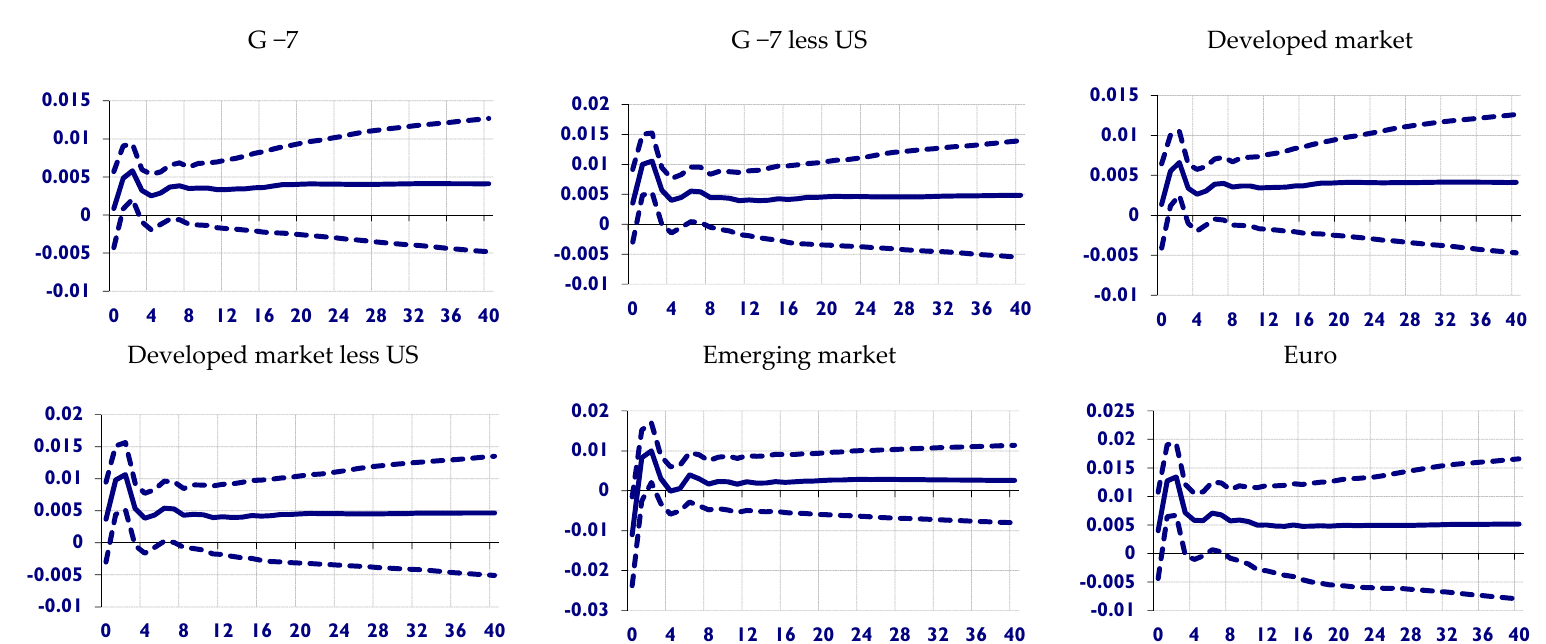
Figure 4. Group Impulse Response Functions of Real Equity Prices to a One Standard Deviation Positive Global Technology Shock (GTS − OECD).